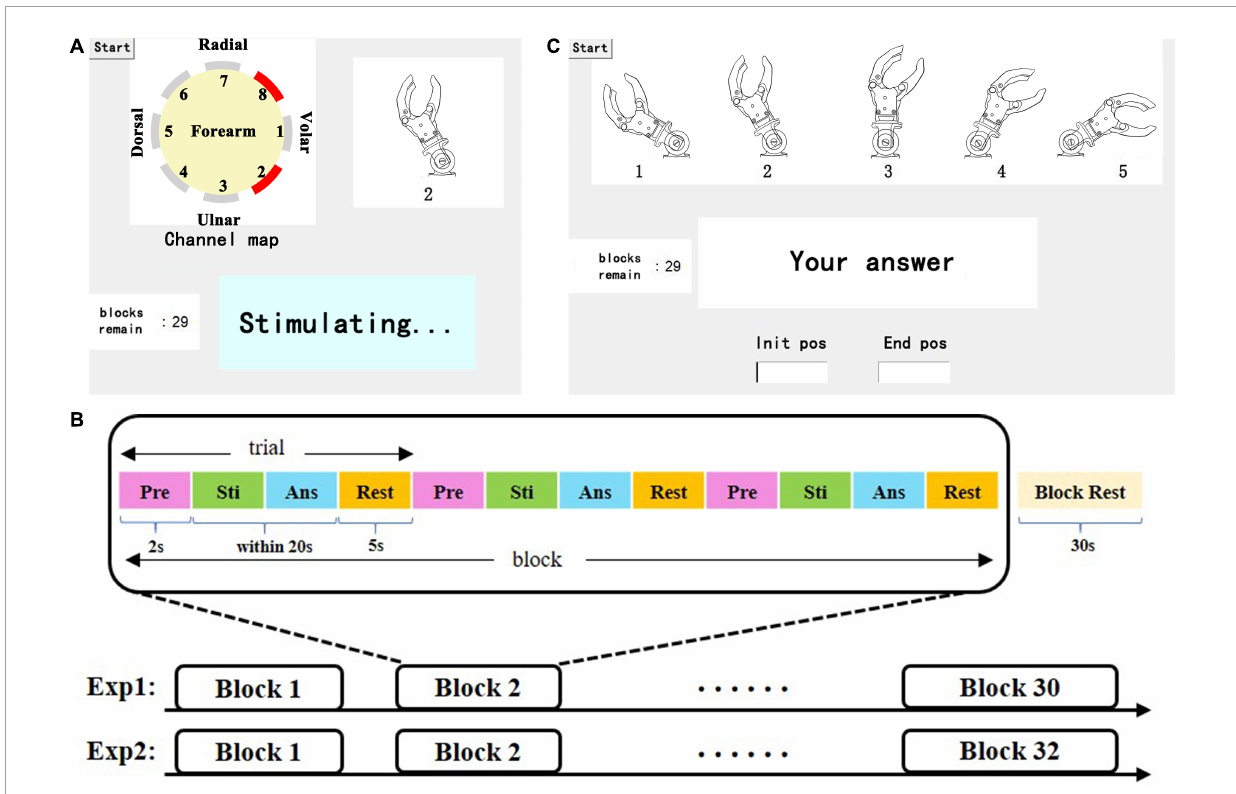
FIGURE3 (A) Representation of the learning session, including a dynamic stimulating channel map, in which the red channel represents the active (under stimulating) channel, the illustrations of wrist FE, real-time status display, and the tip of the remaining blocks. (B) Depiction of the test session, including an illustration of the wrist position index (a static picture), a dialog box, and the tip of the remaining blocks. (C) Paradigm of the experiment, which consists of a certain number of blocks that consist of 3 of the same trials and 30 s of rest. Each trial consisted of four parts: preparation (Pre), stimulation (Sti), answer (Ans) and